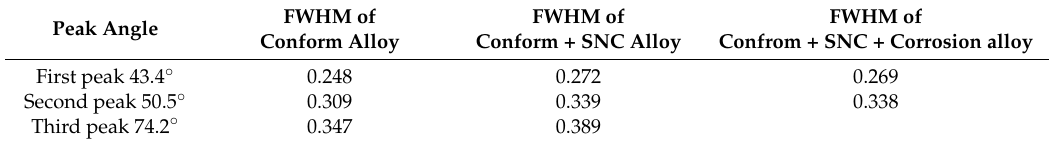
Figure 8. X-ray diffraction (XRD) plots of the conform and conform + SNC Cu-Mg alloys before and after corrosion. Table 2. Crystallographic parameters of the Cu-0.4%Mg alloys via X-ray diffraction (XRD) analysis.